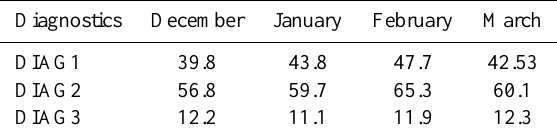
Table 4. Percentage mean change in DIAG1, DIAG2, DIAG3 for the zonally and vertically averaged cloud liquid water over 30 ◦ S– 75 ◦ S latitudinal belt. Table 3. Percentage mean change in DIAG1, DIAG2, DIAG3 for the zonally averaged CD effective radii over 30S-75S latitudinal belt.